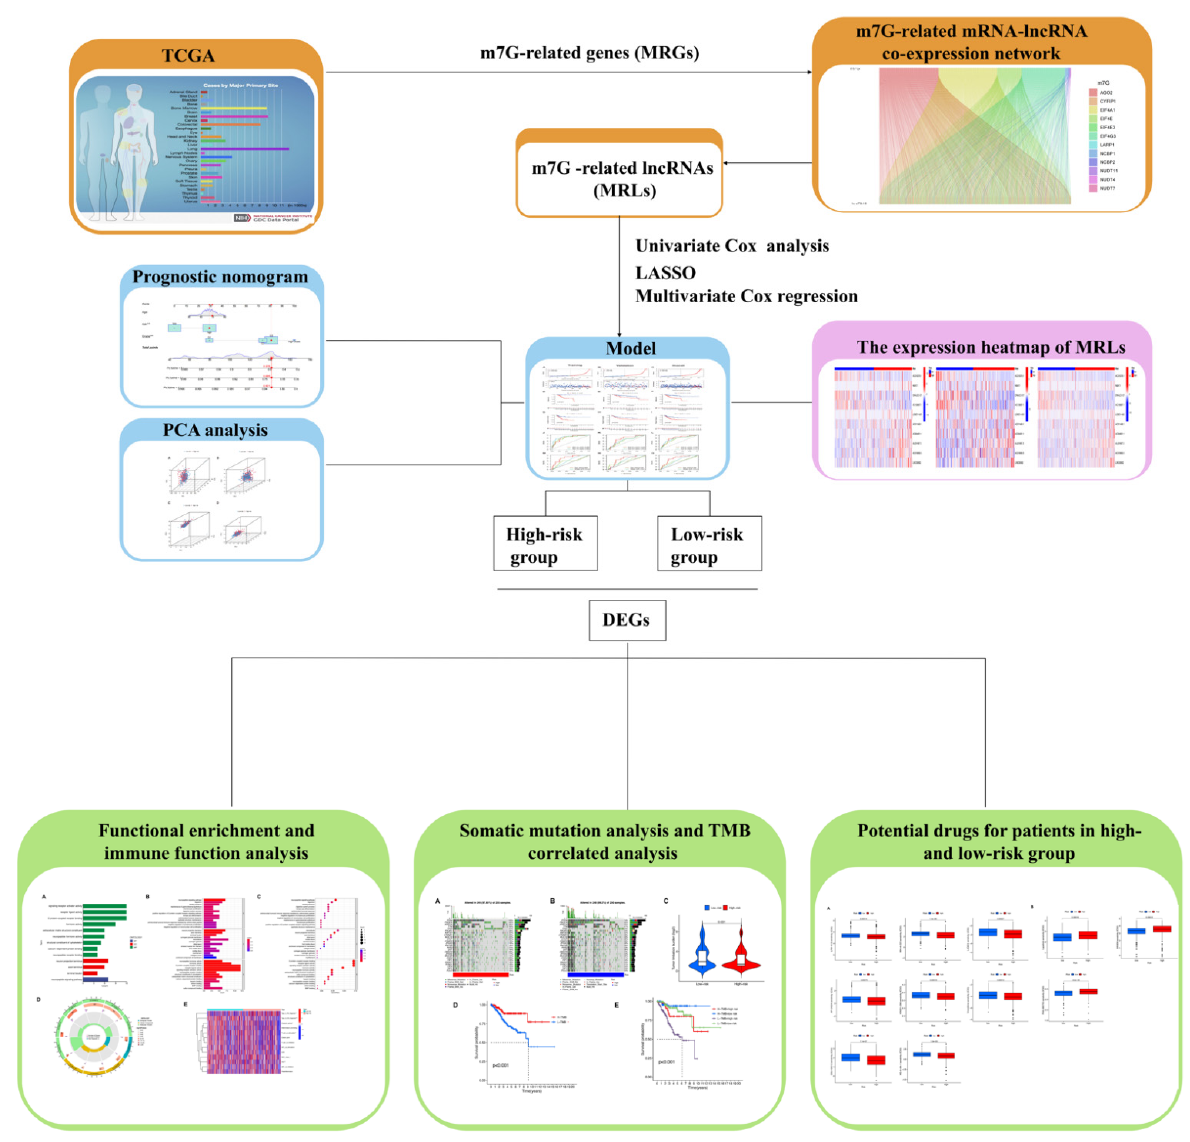
Figure 1. The workflow chart.